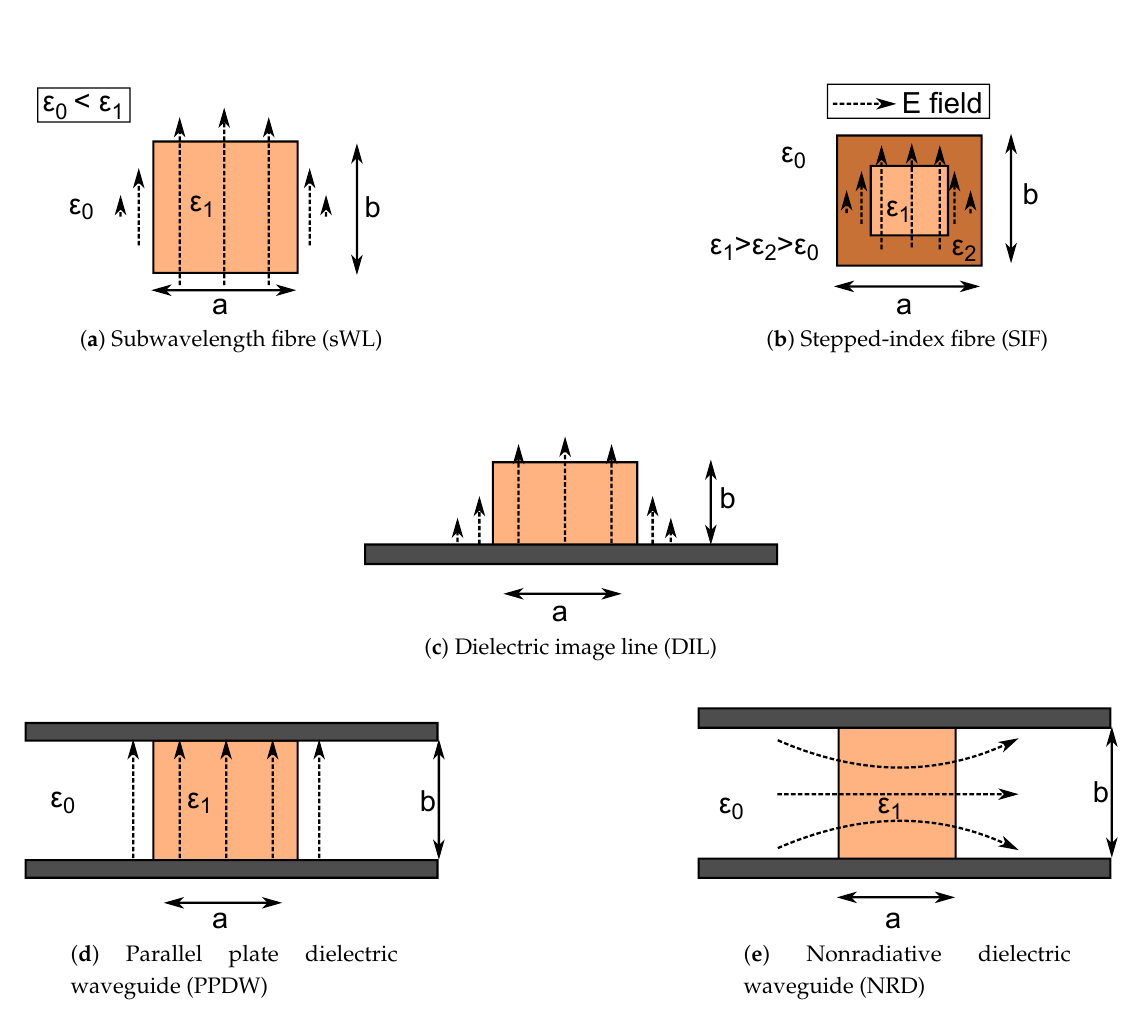
Figure 5. Overview of dielectric waveguide topologies, which have been used for LC phase shifters. ( a ) The rectangular sWL fiber guides the wave in the dielectric and air. ( b ) The SIF consists of a core and cladding material. The wave is completely guided in the dielectrics. ( c ) For the DIL a subwavelength waveguide is halved an mounted on a metal plane. ( d ) The PPDW consisits of a dielectric slab which is inserted between to parallel metal plates. ( e ) The NRD looks similar to the PPDW, except that the dimensions and polarization